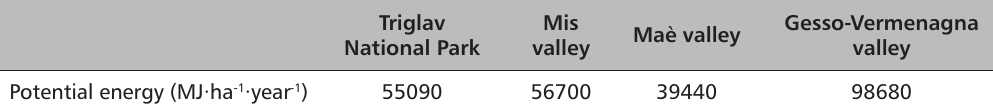
TABle 7. Annual potential energy (I